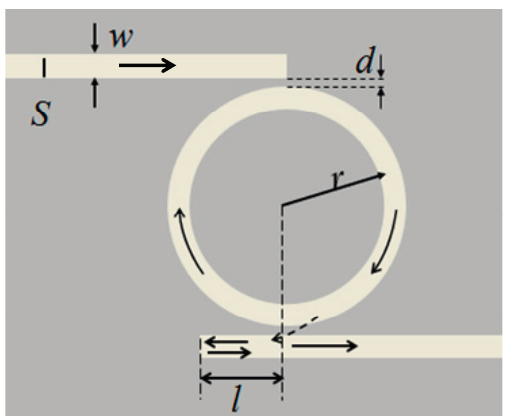
Figure 1. Schematic of the MIM waveguide-coupled ring resonator. S is the dipole source, r is the radius of the ring resonator, d is the coupling distance between the waveguide and ring, and l is the distance between the sealed end of the output waveguide and center of the ring